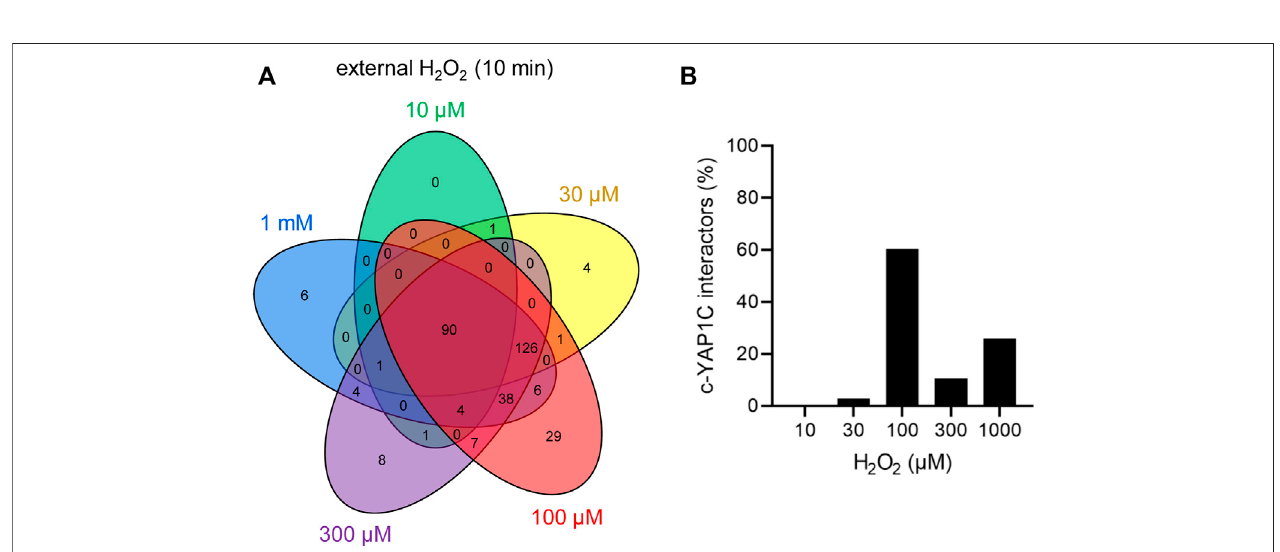
FIGURE7| ThecytosolicsulfenomeinresponsetodifferentconcentrationsofextracellularH 2 O 2 . (A) Venndiagramshowingthenumberandoverlapofsigni fi cantly enrichedinteractorsofc-IBD-SBP-YAP1CupontreatmentofFlp-InT-REx293cellswithdifferentconcentrationsofexternalH